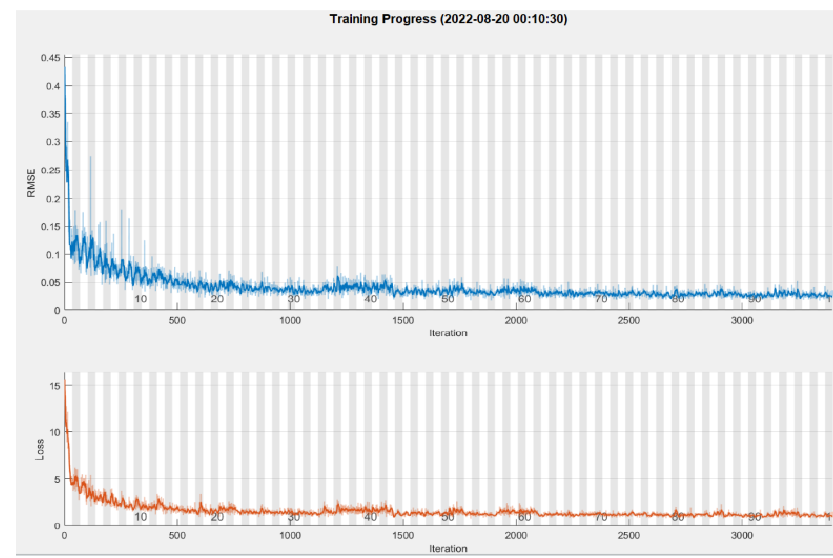
Figure 5. Training convergence process of LSTM network.